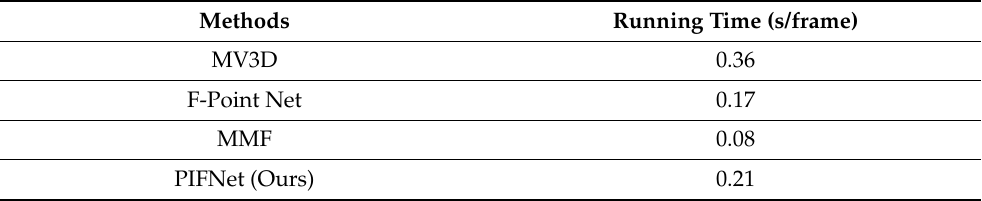
Table 2. Running time comparisons with several camera-LiDAR fusion-based